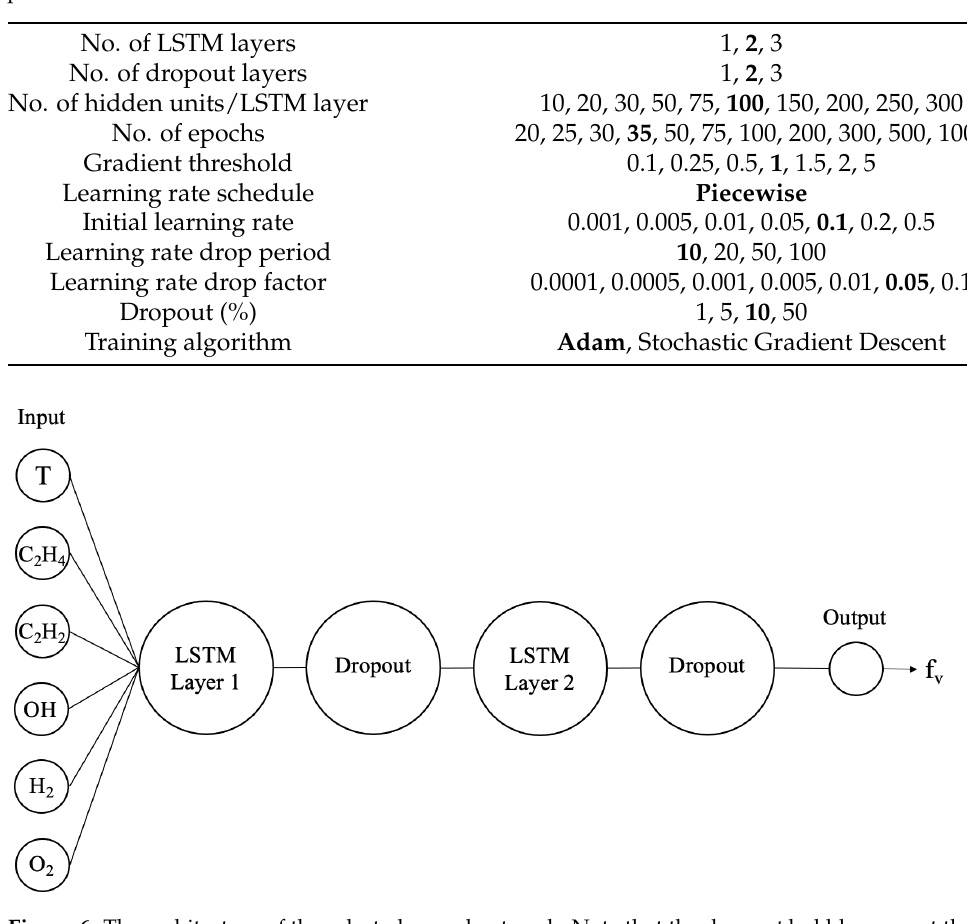
Figure 6. The architecture of the selected neural network. Note that the dropout bubbles are not their own layers of nodes, but they signal that dropout has been applied on the previous layer of